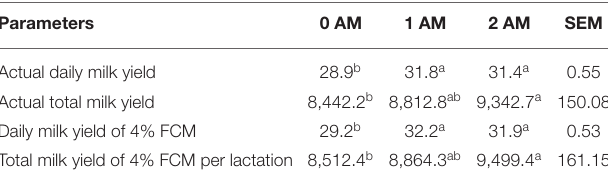
TABLE 6 | The milk from cows (entire lactation season, 305 days) fed different levels of high protein concentrate (kg/cow).